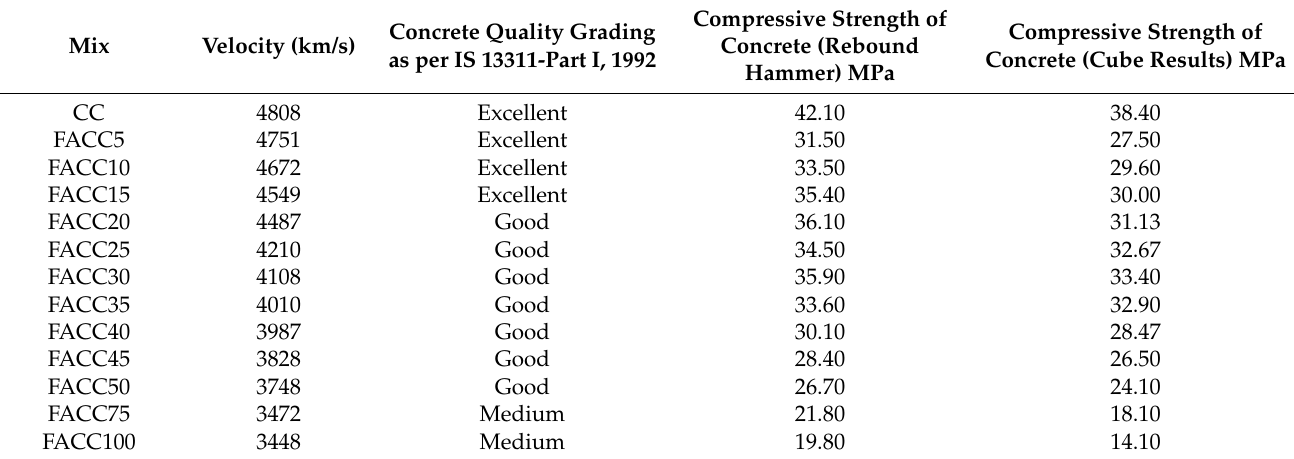
Table 8. UPV and RN Values of CC and FACC.